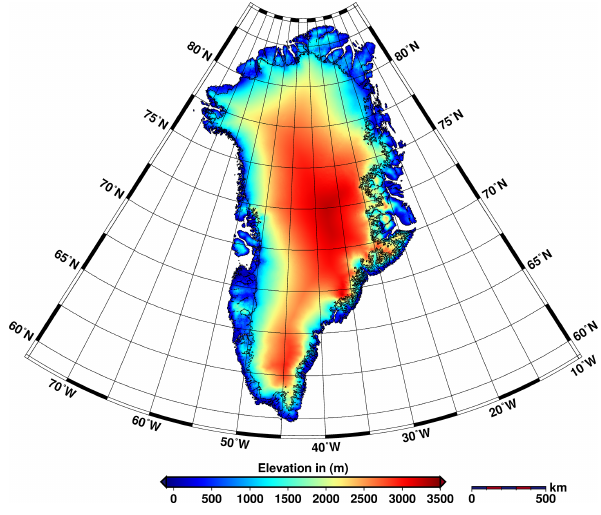
Figure 9. Binned elevation differences with respect to surface slope at a bin size of 0.01 ◦ for Antarctica. The upper panel shows the me- dian of the binned differences and the lower panel its standard devi- ation. Red diamonds represent ICESat cross over differences, blue diamonds Cryosat/ICESat crossover differences, black diamonds the differences between the DEM and ICESat and orange diamonds the expected DEM uncertainty based on the uncertainty